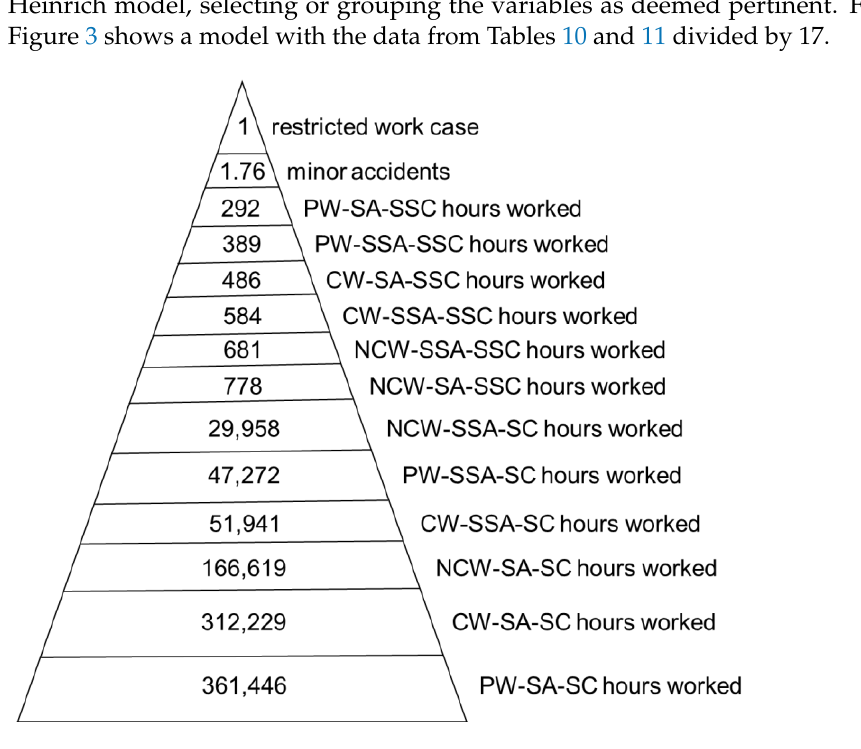
Figure 3. Correlation Models similar to the Heinrich